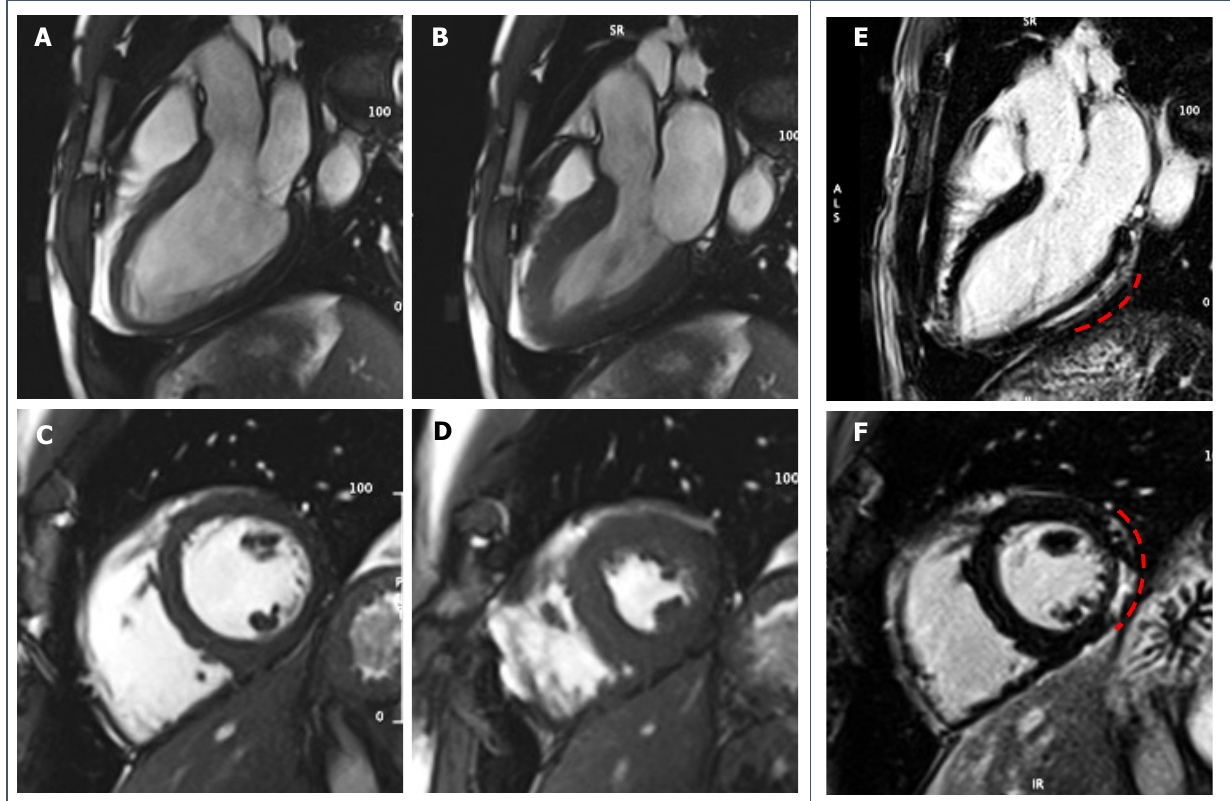
Figure 8. 39-year-old male football player with uncommon ventricular arrhythmias. No sys- Figure 8. 39 ‐ year ‐ old male football player with uncommon ventricular arrhythmias. No systolic tolic dysfunction or wall motion abnormalities are seen on SSFP cine-sequences ( A , B ): diastolic dysfunction or wall motion abnormalities are seen on SSFP cine ‐ sequences ( A ) and ( B ): diastolic and and systolic frames of 3-chambers view; ( C , D ): diastolic and systolic frames of short-axis view. systolic frames of 3 ‐ chambers view; ( C ) and ( D ): diastolic and systolic frames of short ‐ axis view). (E) and ( F ): post ‐ contrast imaging shows a sub ‐ epicardial stria of LGE involving the basal and mid ‐ ( E , F ): post-contrast imaging shows a sub-epicardial stria of LGE involving the basal and middle dle portion of infero ‐ lateral LV wall (red dotted lines). portion of infero-lateral LV wall (red dotted